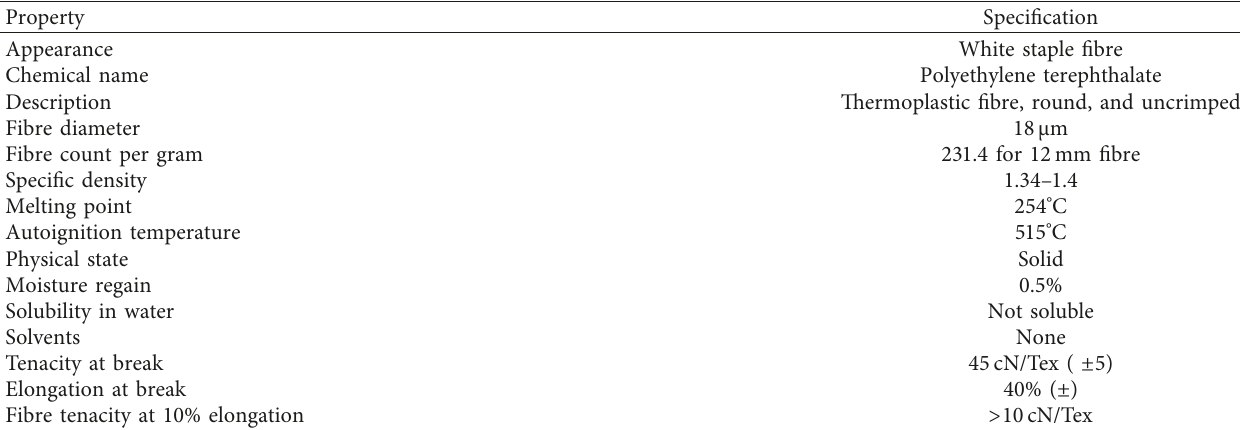
Table 2: Physical properties of PET fibres [29].